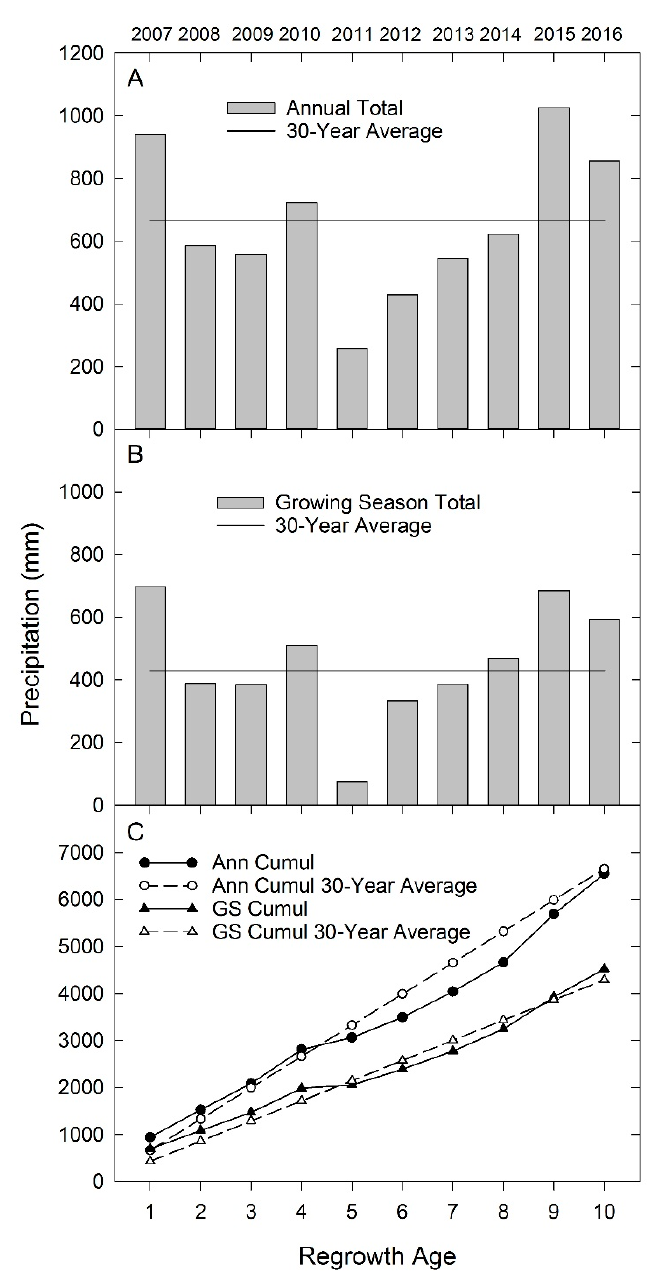
Figure 2. Annual ( A ) and growing season (April-September) ( B ) precipitation totals, and cumulative (Cumul), annual (Ann) and growing season (GS) totals ( C ) at the site compared to the 30-year average, years 1 – 10 (2007 – 2016).